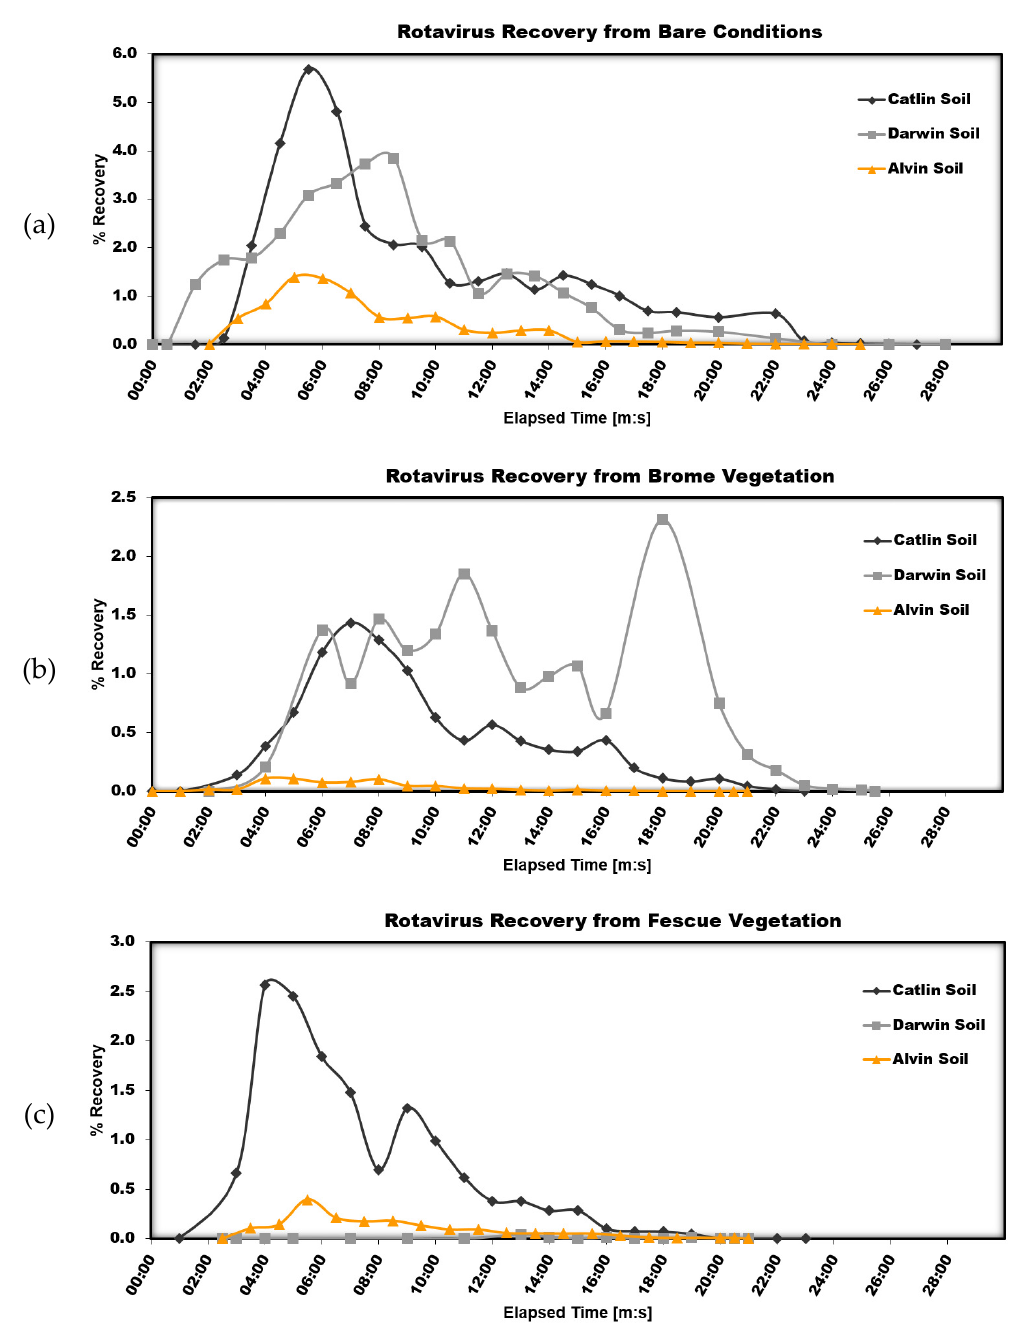
Figure 2. The recovery of infective rotavirus particles from surface runoff is plotted for all three soil types according to surface condition to compare the effect of soil. ( a ) bare soil; ( b ) Brome vegetation; ( c ) Fescue vegetation .